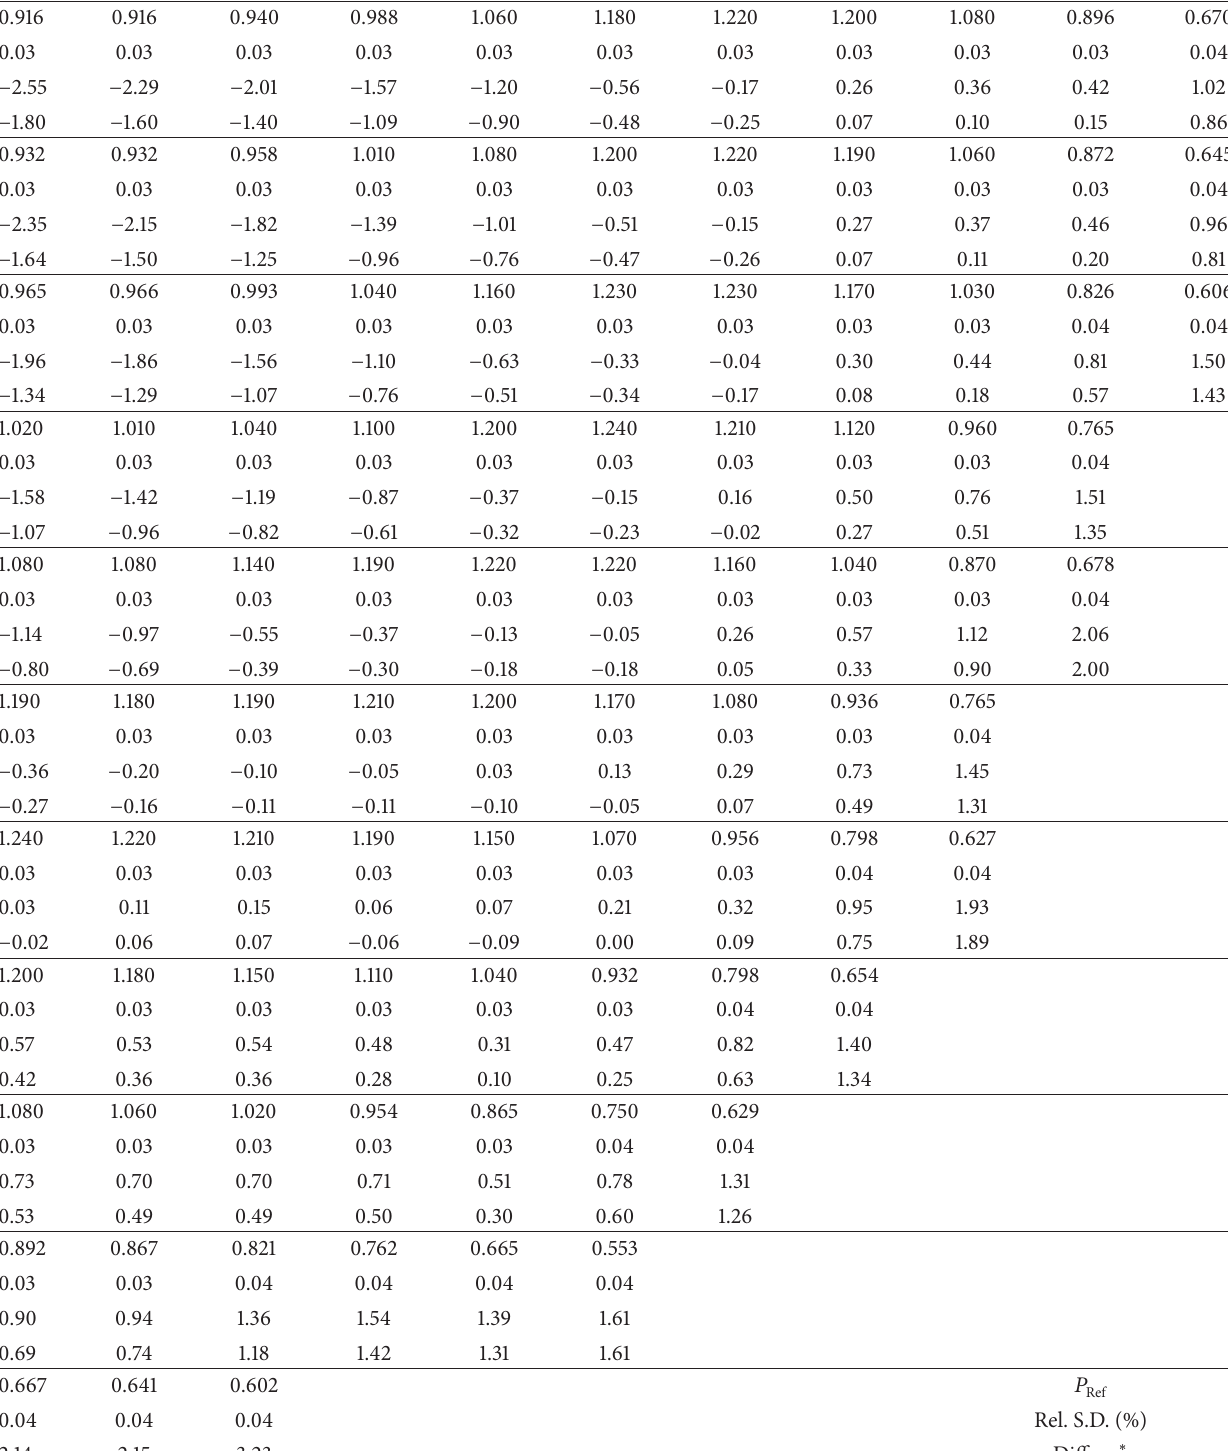
Table 8: Comparison of normalized channel power distribution for the core with all ADJs